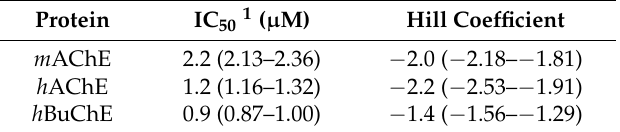
Table 1. IC 50 and Hill coefficient of crystal violet (CV).